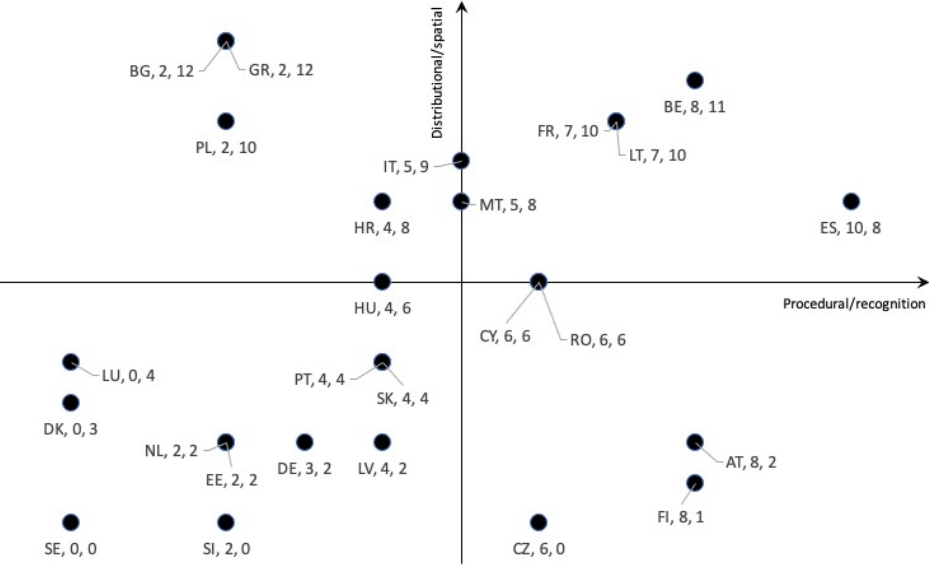
Figure 2. An appraisal of the National Energy and Climate Plans (NECPs) based on “access to justice” (x-axis) and “access to resources” (y-axis). See the Supplementary File for the individual country scores per criterion.